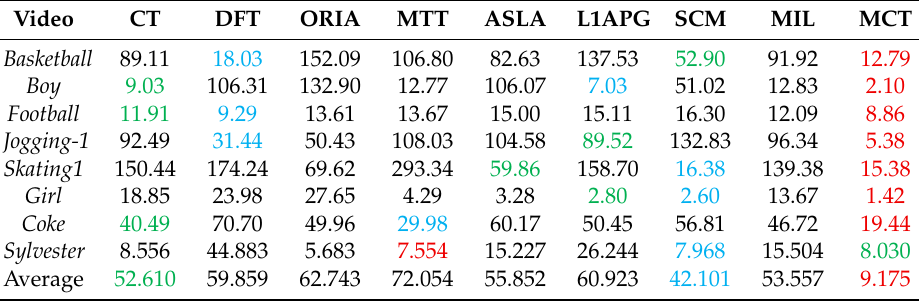
Table 3. Average center location error of the algorithms.